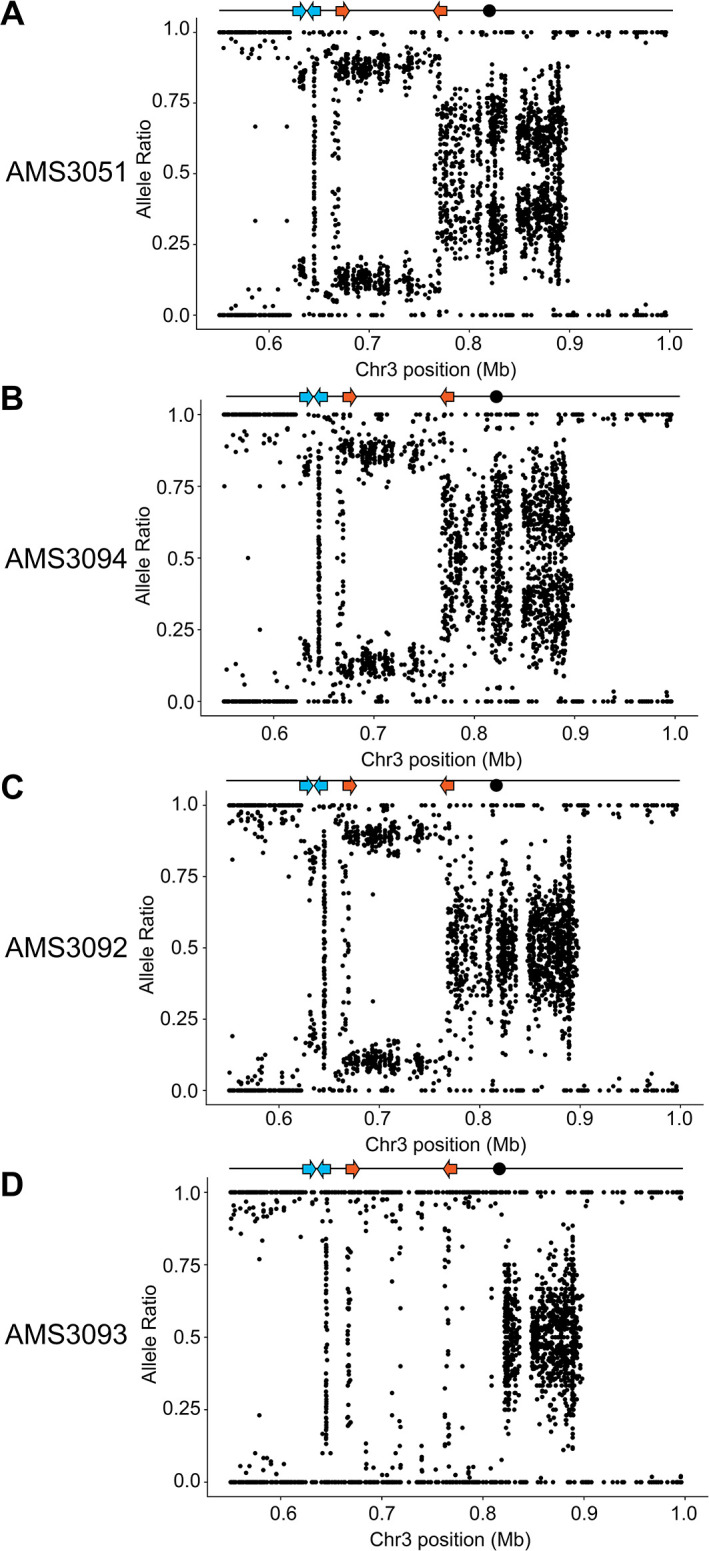
Additional loss of heterozygosity can occur during resolution of complex CNVs.Allele ratio plots of all heterozygous loci on Chr3 for (A) the CNV-containing progenitor isolate AMS3051, and three single colonies isolated from AMS3051 in the absence of antifungal drug (B–D). Location of the long inverted repeats (blue and orange arrows) and CEN3 (black dot) are shown above each plot. The progenitor to AMS3051 is homozygous on Chr3R from position 896,538 to the Chr3R telomere. (B) AMS3094 maintains the entire Chr3 CNV structure and allele frequency ratios similar to AMS3051. (C) AMS3092, which kept the complex stair-step CNV on Chr3L but became disomic for both Chr3R and the telomere proximal region of Chr3L, returned to a ~50% allele frequency ratio between the CNV and CEN3 while remaining homozygous for the telomere proximal disomic region of Chr3L. (D) Recombination near CEN3 resulted in LOH and loss of the CNV. The euploid strain AMS3093 became homozygous for the entire left arm of Chr3 while remaining heterozygous to the right of CEN3.